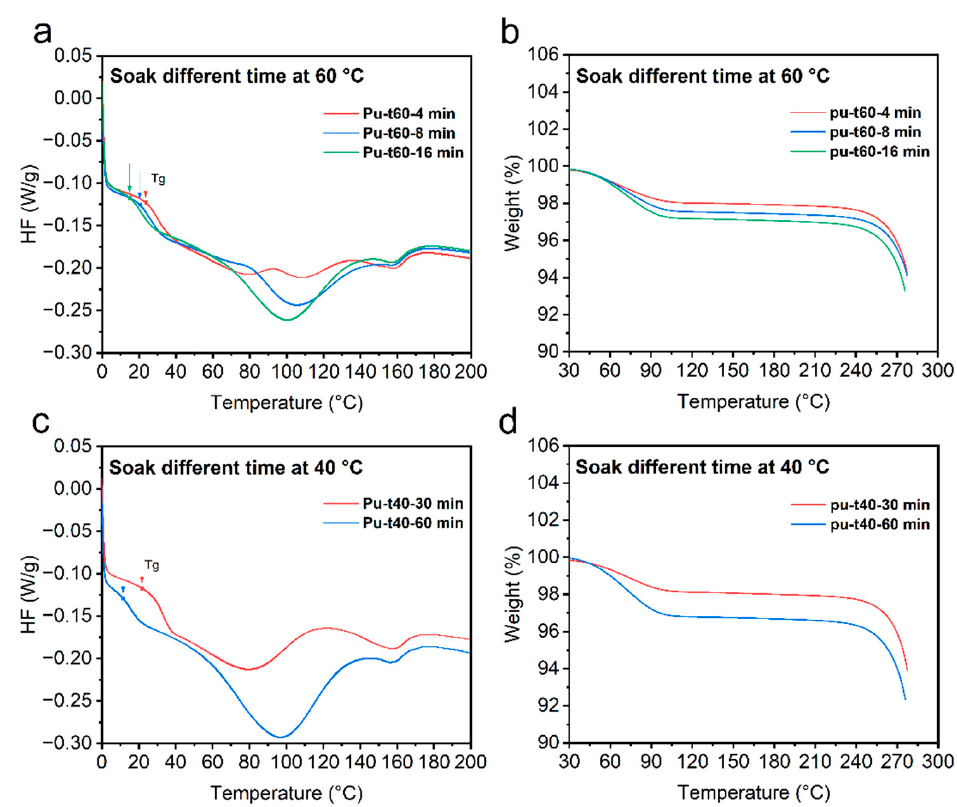
Figure 5. DCS experiments of bio-inspired spider silk samples soaked at 60 °C ( a ); TGA experiments of bio-inspired spider silk samples soaked at 60 °C ( b ); DCS experiments of bio-inspired spider silk samples soaked at 40 °C ( c ); TGA experiments of bio-inspired spider silk samples soaked at 40 °C ( d ).